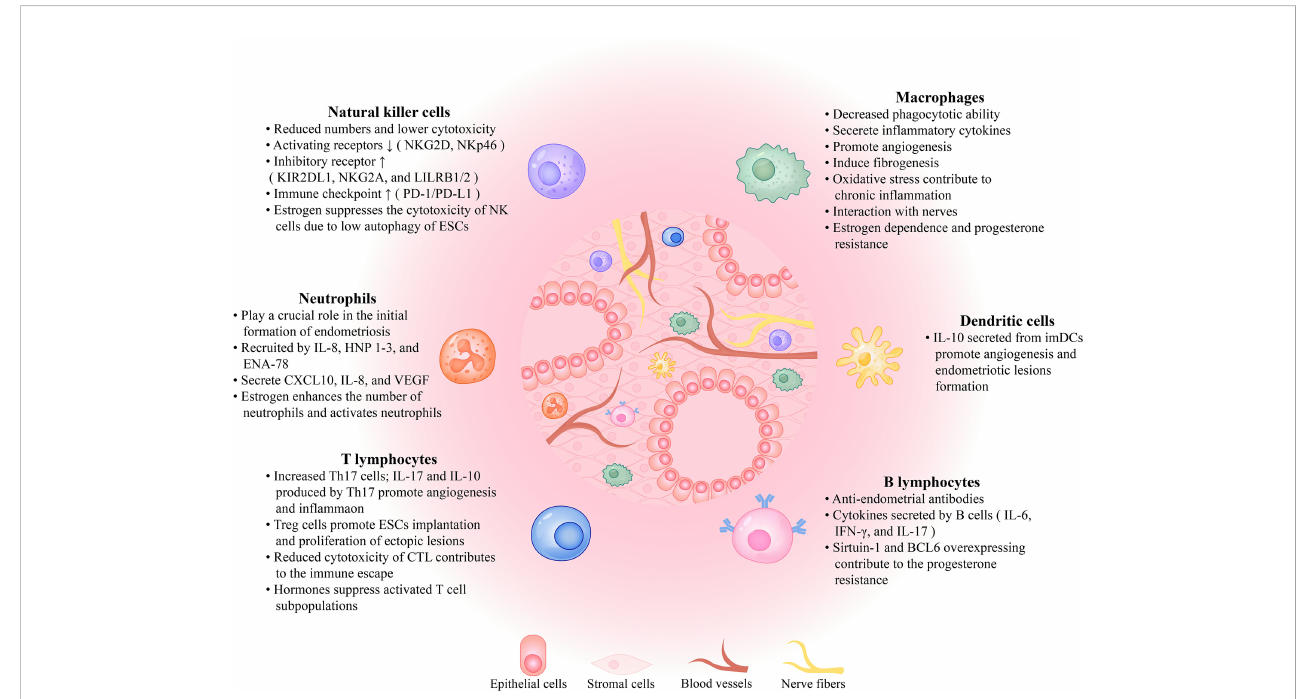
FIGURE 1 The immune microenvironment in the peritoneal cavity of the patient with endometriosis. Endometriotic lesions are comprised of epithelial cells, stromal cells, blood vessels, and nerve fi bers that interact with immune cells, such as macrophages, natural killer cells, dendritic cells, neutrophils, B lymphocytes, and T lymphocytes, as well as a variety of cytokines, all of which contribute to the formation of the immune microenvironment. The role each component plays in the growth and development of endometriotic lesions is described here. NKG2D, NK Group 2, Member D; LILRB1/2, leukocyte immunoglobulin-like receptor B1/2; PD-1/PD-L1, programmed cell death protein 1/programmed cell death ligand 1; ESCs, endometrial stromal cells; IL, interleukin; HNP 1-3, human neutrophil peptides 1, 2, and 3; ENA-78, epithelial neutrophil-activating protein-78; VEGF, vascular endothelial growth factor; Th17 cells, T helper 17 cells; CTL, cytotoxic T lymphocytes; imDCs, immature dendritic cells; IFN- g , interferon- g ; BCL6, B cell lymphoma